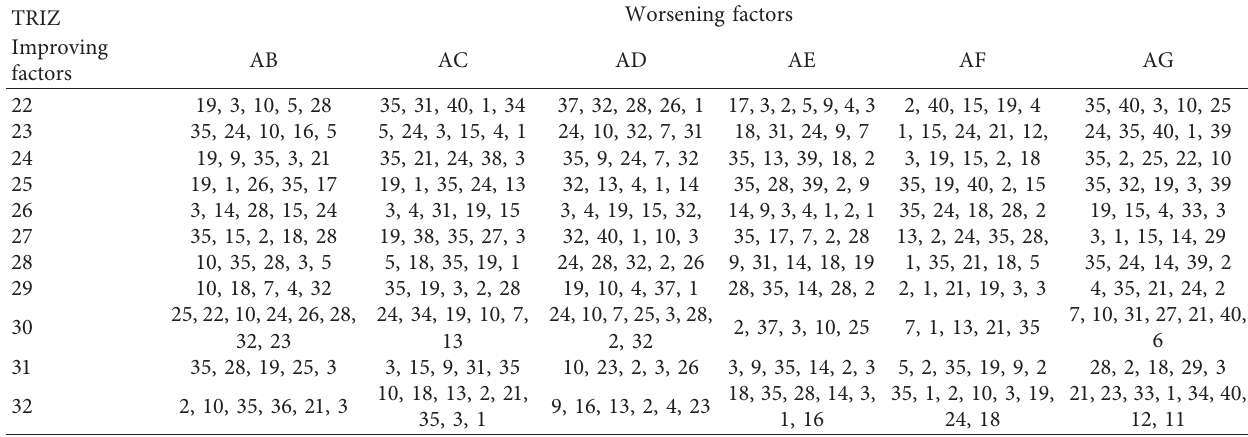
Table 1: The contradiction matrix of TRIZ